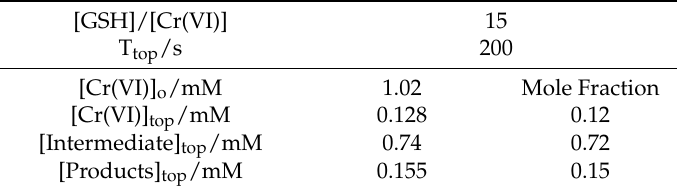
Table 1. Distribution of chromium in the reaction between Cr(VI) and glutathione in 100 mM glycine at the time when [Intermediate] is at maximum concentration (t top ).